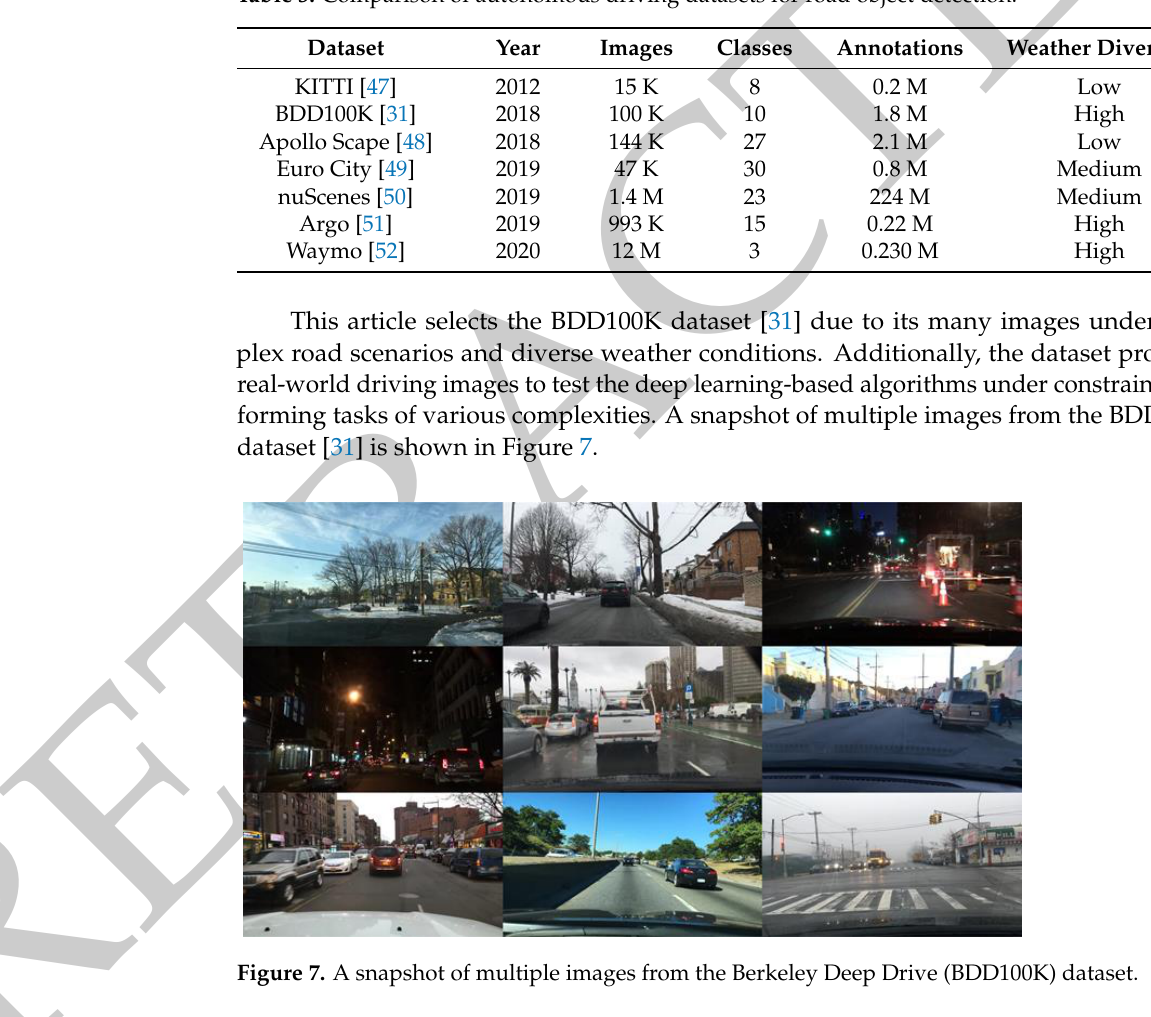
Table 3. Comparison of autonomous driving datasets for road object detection.